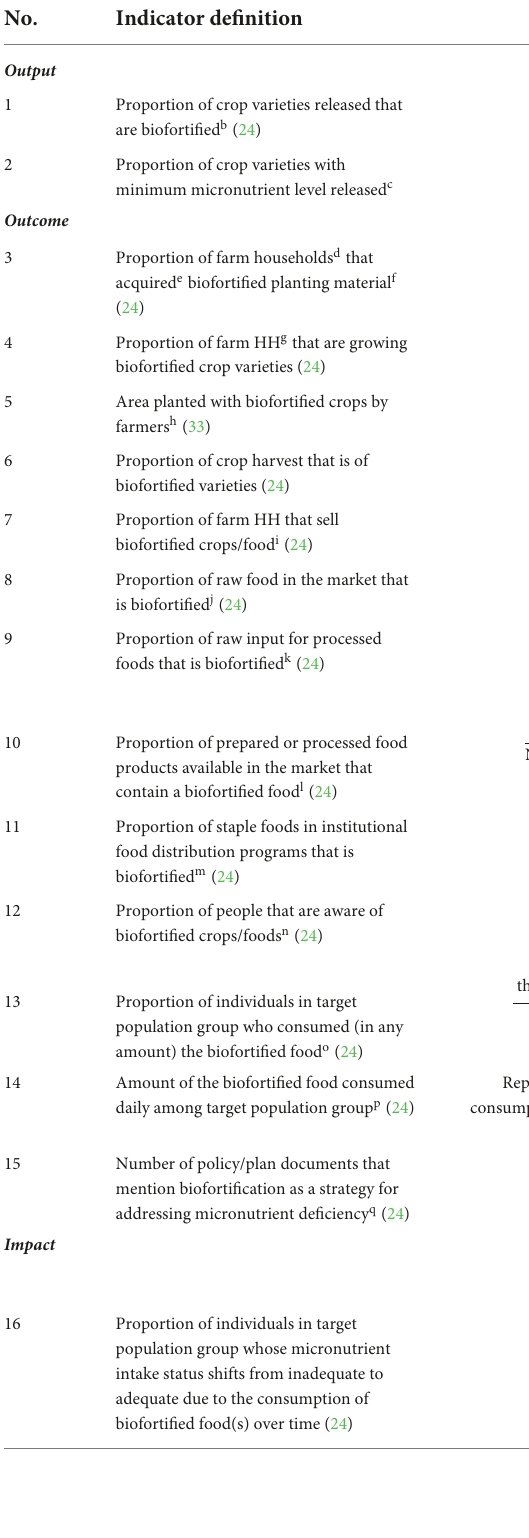
TABLE 6 High-level indicators and metrics for M&E of biofortification